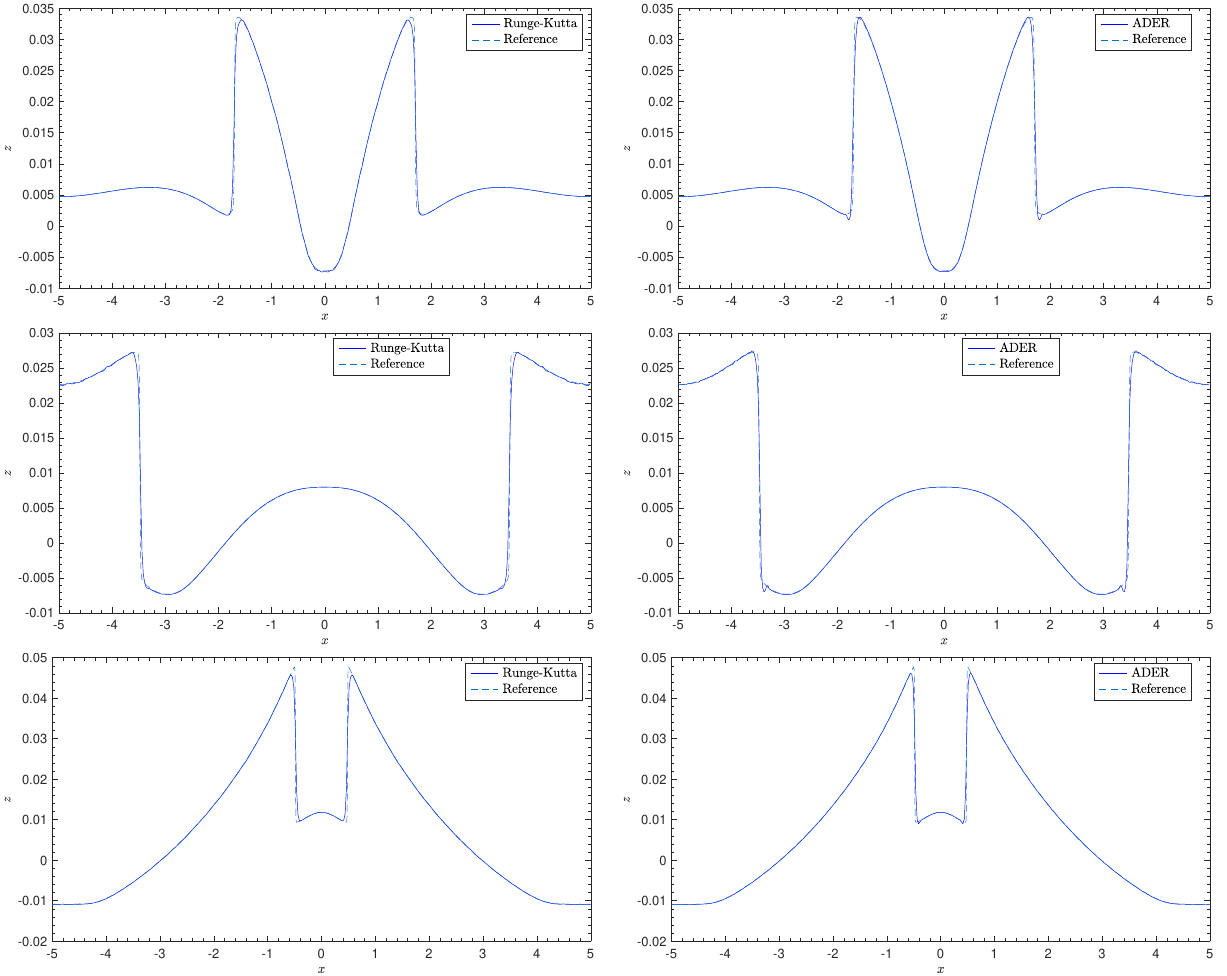
Figure 8. Computed free surface for the problem (54) (shallow water equations) with the fourth-order well-balanced Runge–Kutta ( left ) and ADER ( right ) numerical methods at times t = 4, 5.5, 6.5 s (from upper to lower panels). An uniform Cartesian mesh of N x = 400 elements has been